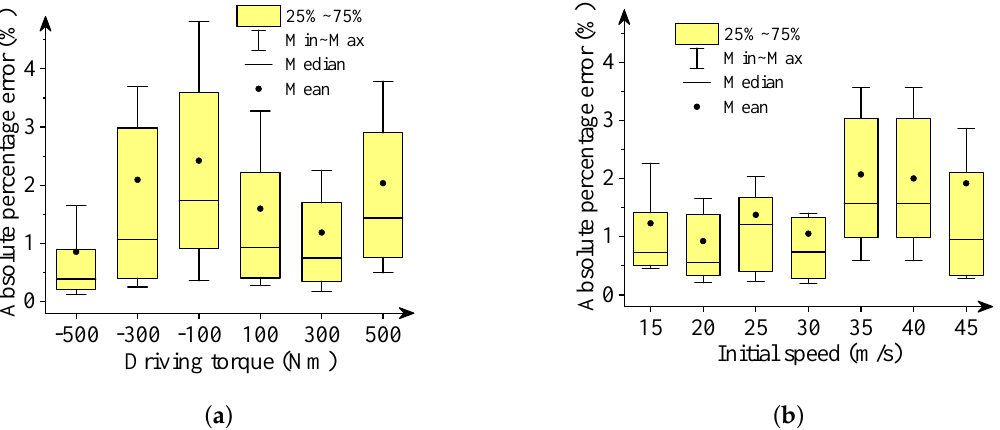
Figure 7. Box plots of percentage absolute error: final lateral distance. ( a ) Driving torque; ( b ) Ini- tial speed.